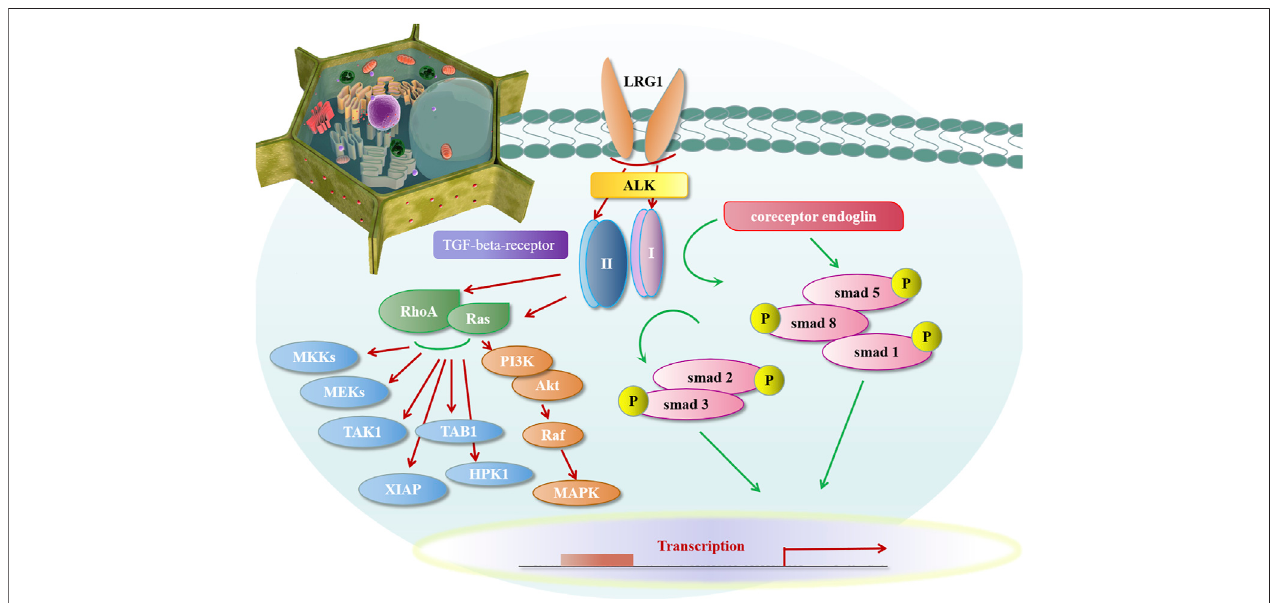
FIGURE 2 | LRG1 activated TGF- β signaling